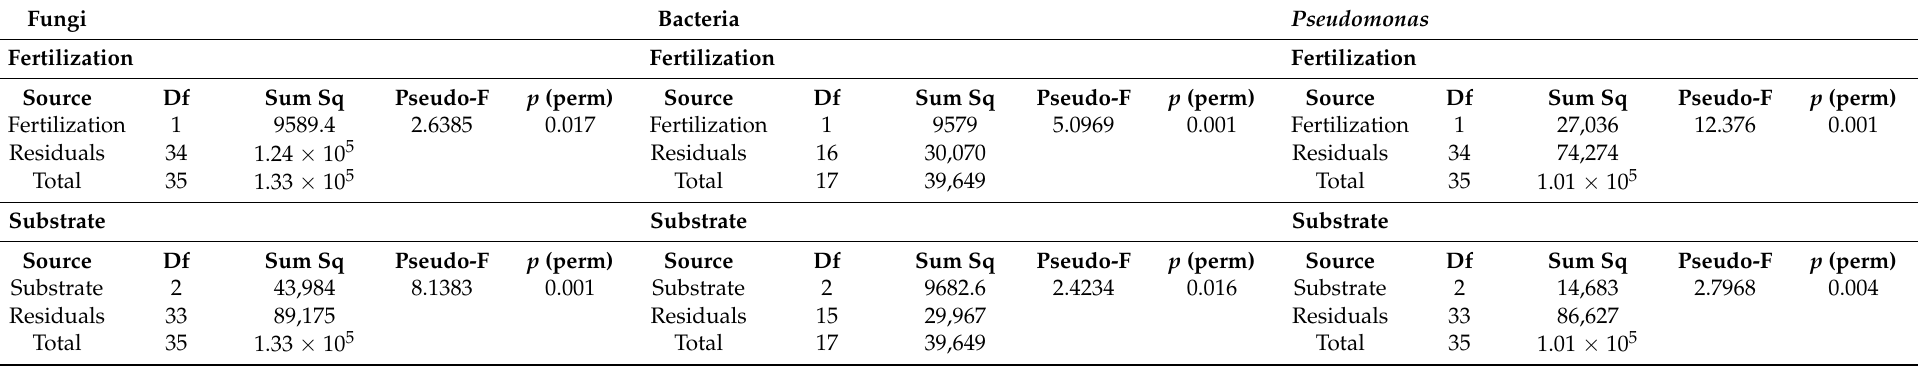
Table 3. Results of the PERMANOVA analysis to test the effect of fertilization and substrate on the cultivable microbial communities (Fungi, Bacteria, and the genus Pseudomonas ).